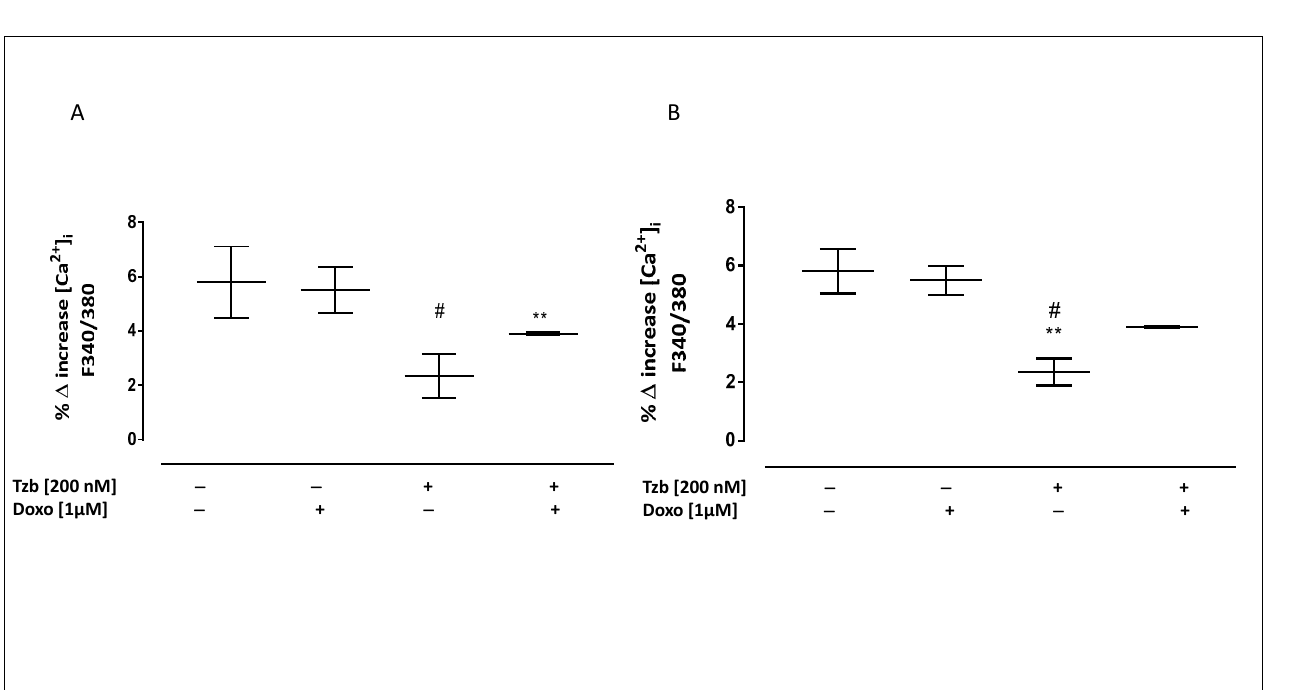
Figure 3. Effect of Doxo and Tzb and their association with calcium homeostasis. Doxo (1 µ M) was administered for 4 h, and Tzb (200 nM) was administered for 20 h. Mitochondrial calcium pool was evaluated on H9c2 cells in calcium-free medium in the presence of FCCP (50 nM) (panel ( A )). Panel ( B ) shows the intracellular calcium content in calcium-free medium evaluated by means of Ionomycin (1 µ M). Results are expressed as mean ± S.E.M. of percentage of delta (% ∆ ) increase in FURA 2 ratio fluorescence (340/380 nm) from at least three independent experiments, each performed in duplicate. Data were analysed by variance test analysis, and multiple comparisons were made by Bonferroni’s test. ** p < 0.005 vs. non-treated cells, # p < 0.05 vs. Doxo-treated